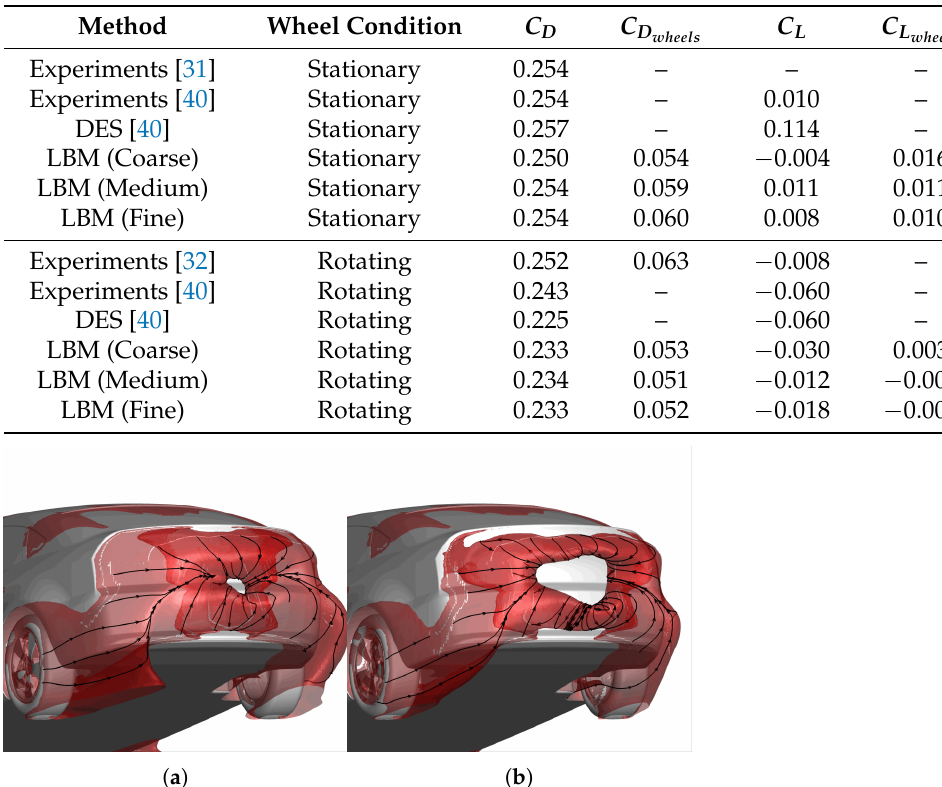
Table 2. Comparison of force coefficients using different meshes and wheel conditions. The subscript wheels denotes the force coefficients attributed directly to the wheels (i.e., the difference in force coefficients between the total vehicle and the vehicle body).